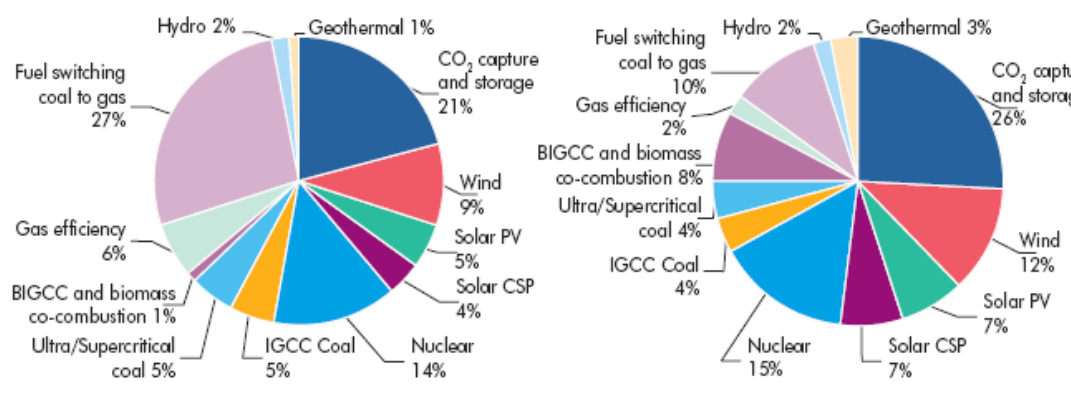
Figure 9. Reductions of CO emissions in the IEA ACT and BLUE scenarios. © 2008 2 OECD/IEA, reproduced from [2] with